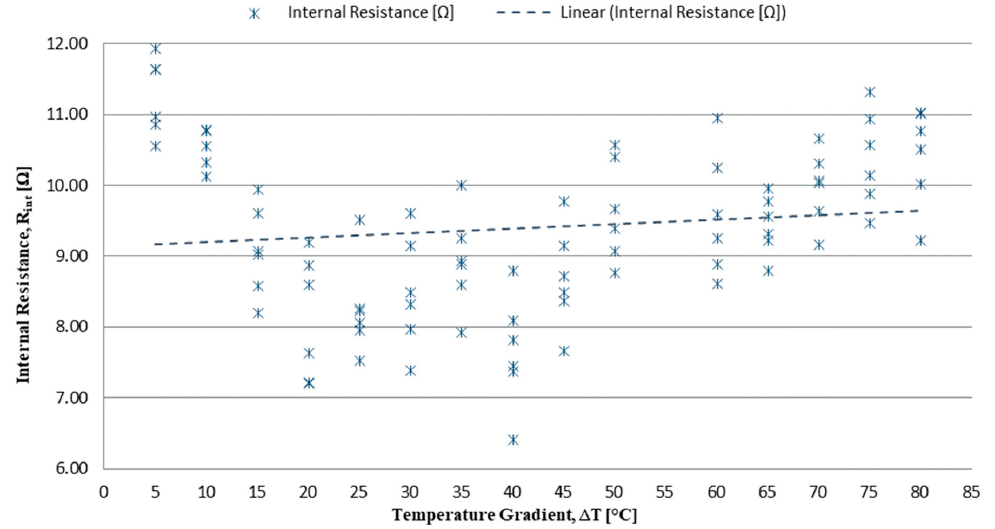
Figure 4. Demonstration of internal resistance (R int ) samples as measured in the test.